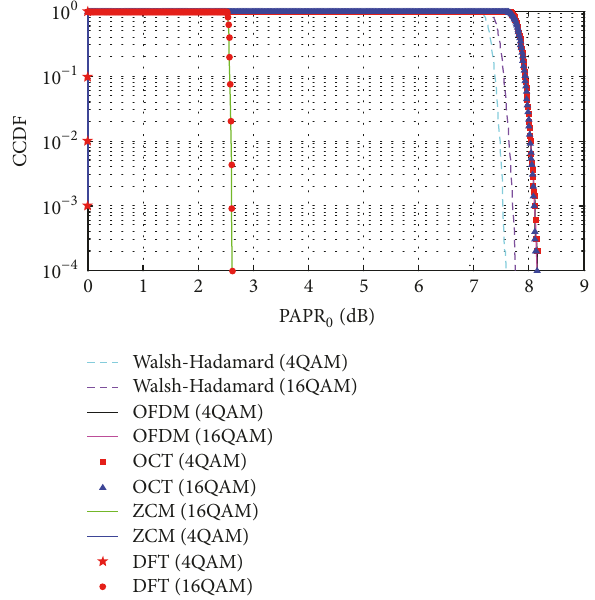
Figure 2: CCDF of PAPRs for the different precoding